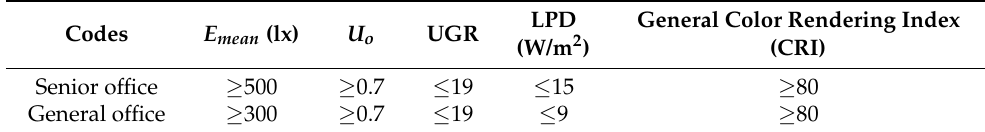
Table 2. Office lighting standards 1 .